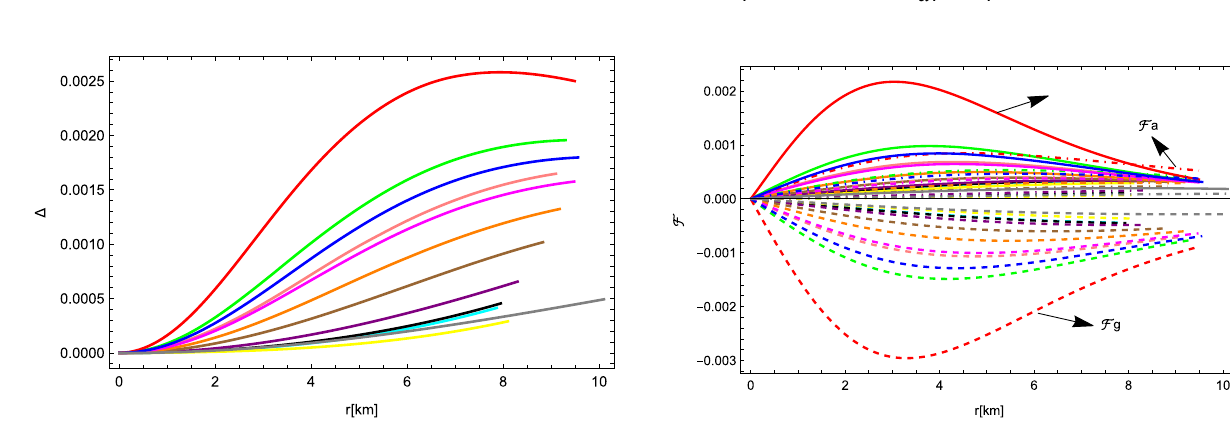
Fig. 4 Evolution of (cid:21) of S 1 ( (cid:2) ), S 2 ( (cid:2) ), S 3 ( (cid:2) ), S 4 ( (cid:2) ), S 5 ( (cid:2) ), S 6 ( (cid:2) ), S 7 ( (cid:2) ), S 8 ( (cid:2) ), S 9 ( (cid:2) ), S 10 ( (cid:2) ), S 11 ( (cid:2) ), S 12 ( (cid:2) )